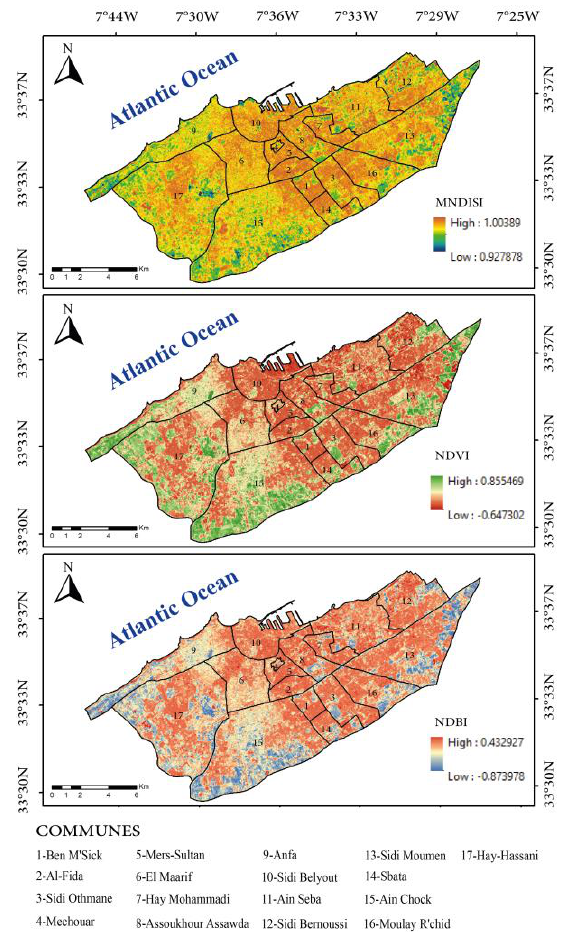
Figure 3 . MNDISI NDVI and NDBI.